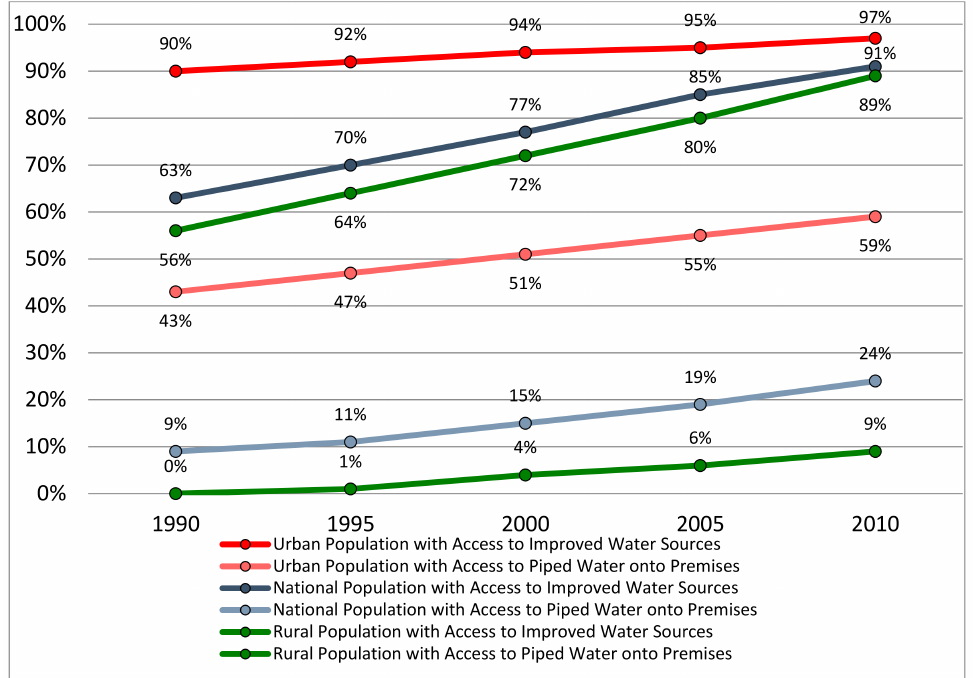
Figure 3. Detailed Indonesia’s Longitudinal Changes in Access to Improved Water Sources. Source: (UNICEF and WHO 2013a).